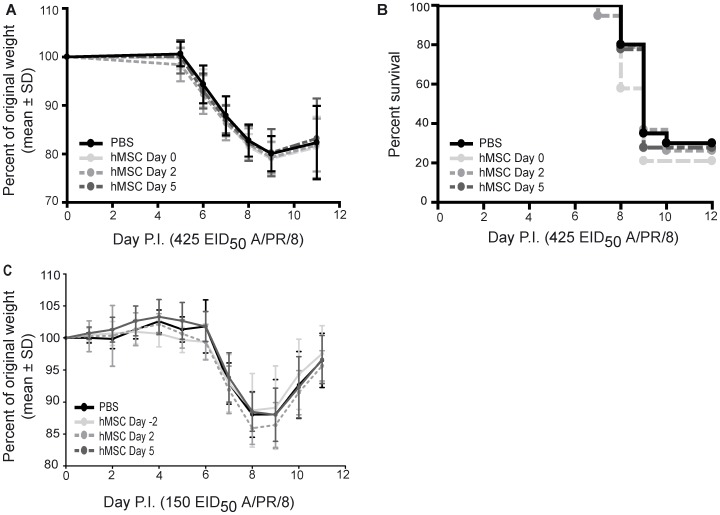
Neither prophylactic nor therapeutic administration of hMSCs altered weight loss or improved survival in either experimental severe or non-lethal influenza.Eight week-old male C57Bl/6 mice were infected with 425 EID50 (lethal model) or 150 EID50 influenza A/PR/8 virus (sub-lethal model) and administered 2.5×105 hMSCs (passage 3) or PBS, via the tail vein, either prophylactically (2 days or 4 hours (day 0) prior to infection) or therapeutically (day 2 or day 5 P.I.). Weight was recorded daily. No significant differences in (A) weight loss kinetics (two-way ANOVA, n = 18–20/group, 2 pooled experiments) or (B) survival (logrank test, n = 18–20/group, 2 pooled experiments) were observed in the lethal influenza model. (C) No significant differences in weight loss kinetics were observed in the sub-lethal influenza model (two-way ANOVA, n = 11/group). Error bars represent standard deviation.